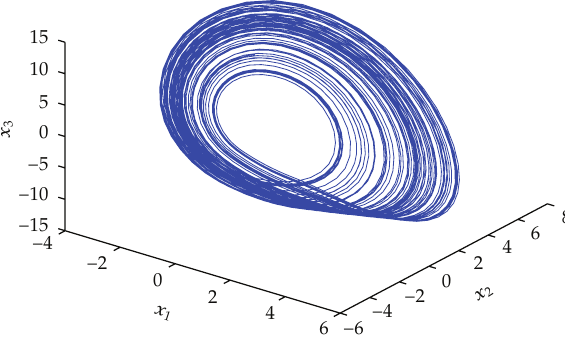
Figure 1: Phase portraits of the nominal autonomous system (cid:2) 3.1 (cid:3) with parameters (cid:2) 4.5 (cid:3)